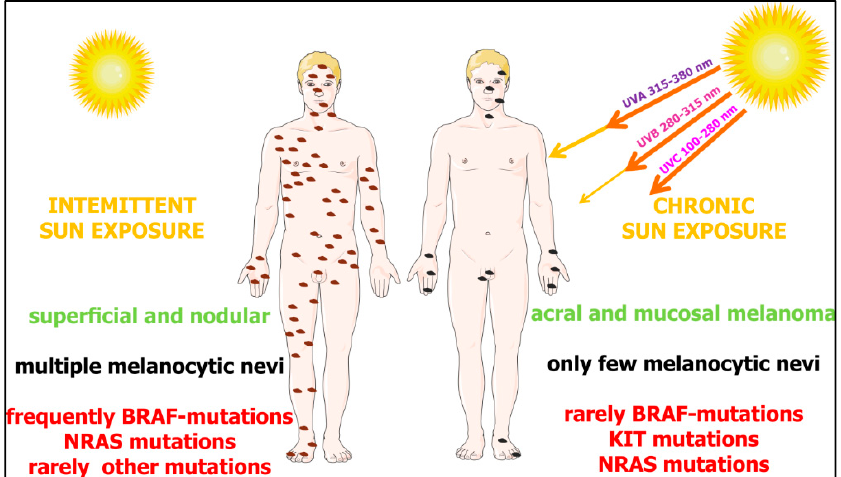
Figure 2. Differential dependence of melanoma subgroups on sun exposure and types of gene mutations. The interplay of genetic and environmental factors on melanoma development. Up to 50% of melanomas derived from the skin without chronic sun damage (intermittently exposed to UV) contain BRAF mutations. The second frequent mutations are present in the NRAS gene (around 25%). In melanomas derived from chronic sun exposure, NRAS and KIT mutations are more common (~15% and ~20%) than BRAF (~10%). According to Janina Staub (2012) with some modifications [30,31].